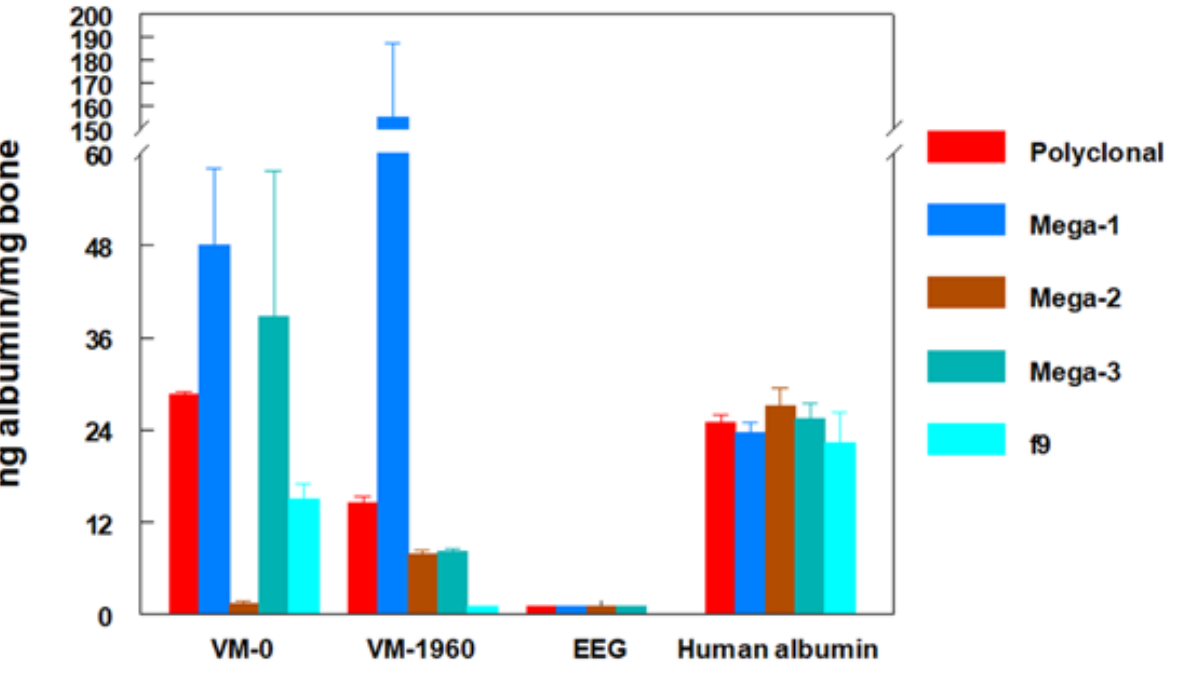
Figure 4. Enzyme-linked immunosorbent quantification of albumin in EDTA extracts of fossils VM- 0 and VM-1960, assigned to hominins, and fossil EEG, assigned to an equid, with monoclonal anti- bodies. Four monoclonal anti-human albumin antibodies (MEGA-1, MEGA-2, MEGA-3 and 8F6F9) were used with the fossils. Polyclonal mouse anti-human albumin serum was used for comparison. Human albumin (25 ng) was tested for comparison. From Lowenstein et al. [45], with permission.